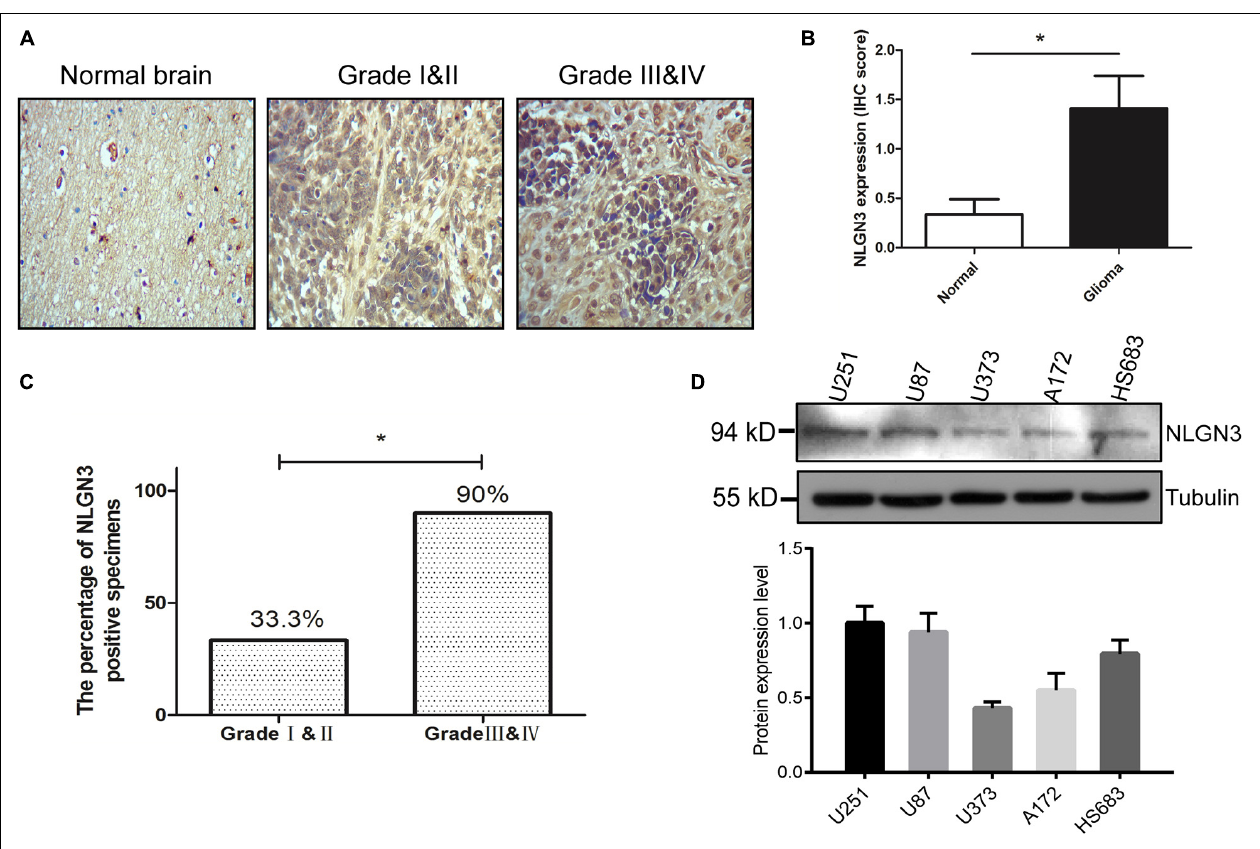
FIGURE 1 | NLGN3 was overexpressed in human glioma. (A) The expression level of NLGN3 in human glioma was detected by IHC, and normal brain tissue was used as the control. The magnification of the image was 100x. (B) Statistical analysis of NLGN3 expression in glioma and normal tissues. (C) The percentage of NLGN3 positive specimens in high-grade glioma was significantly higher in comparison to low-grade glioma. (D) NLGN3 expression in five human glioma cell lines, U87, U251, HS683, A172, and U373, was detected using Western blot analysis. U251 and U87 cells showed higher levels of NLGN3 and were used for subsequent experiments. * p <